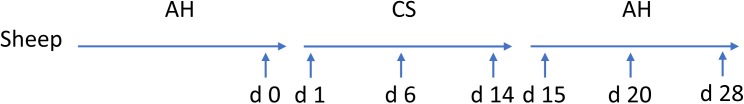
Experimental design and sample collection time points. Five sheep were tracked across dietary transition. Diet transitioned from alfalfa hay (AH) to corn stover (CS) and back to AH, with each dietary treatment lasting for 14 days. Sample collection implemented on day 0, the previous day before first transition, and days 1, 6, 14, 15, 20, and 28 subsequently.